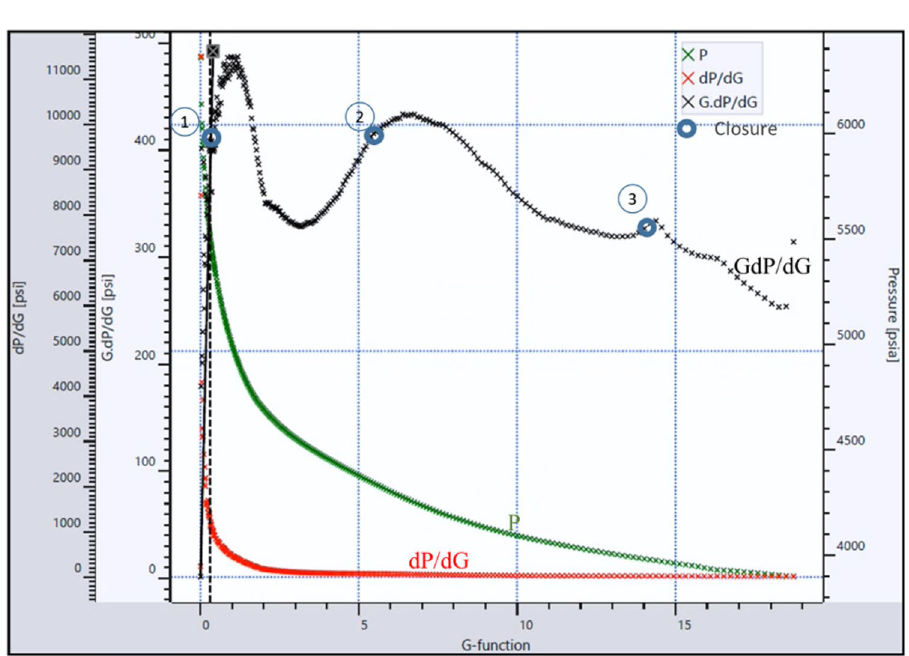
Fig. 11 Log–log diagnostic plot for Cycle #4. The type of the flow, before and after closure, is determined based on the slopes which are shown by dashed lines. The ½ slope in the semilog drawdown derivative curve implies fracture linear flow before closure. In this case, the Bourdet derivative is not showing the closure. Drawdown derivative is (∆ t d∆ P /d∆ t ), and semilog derivative is referring to the Bourdet derivative